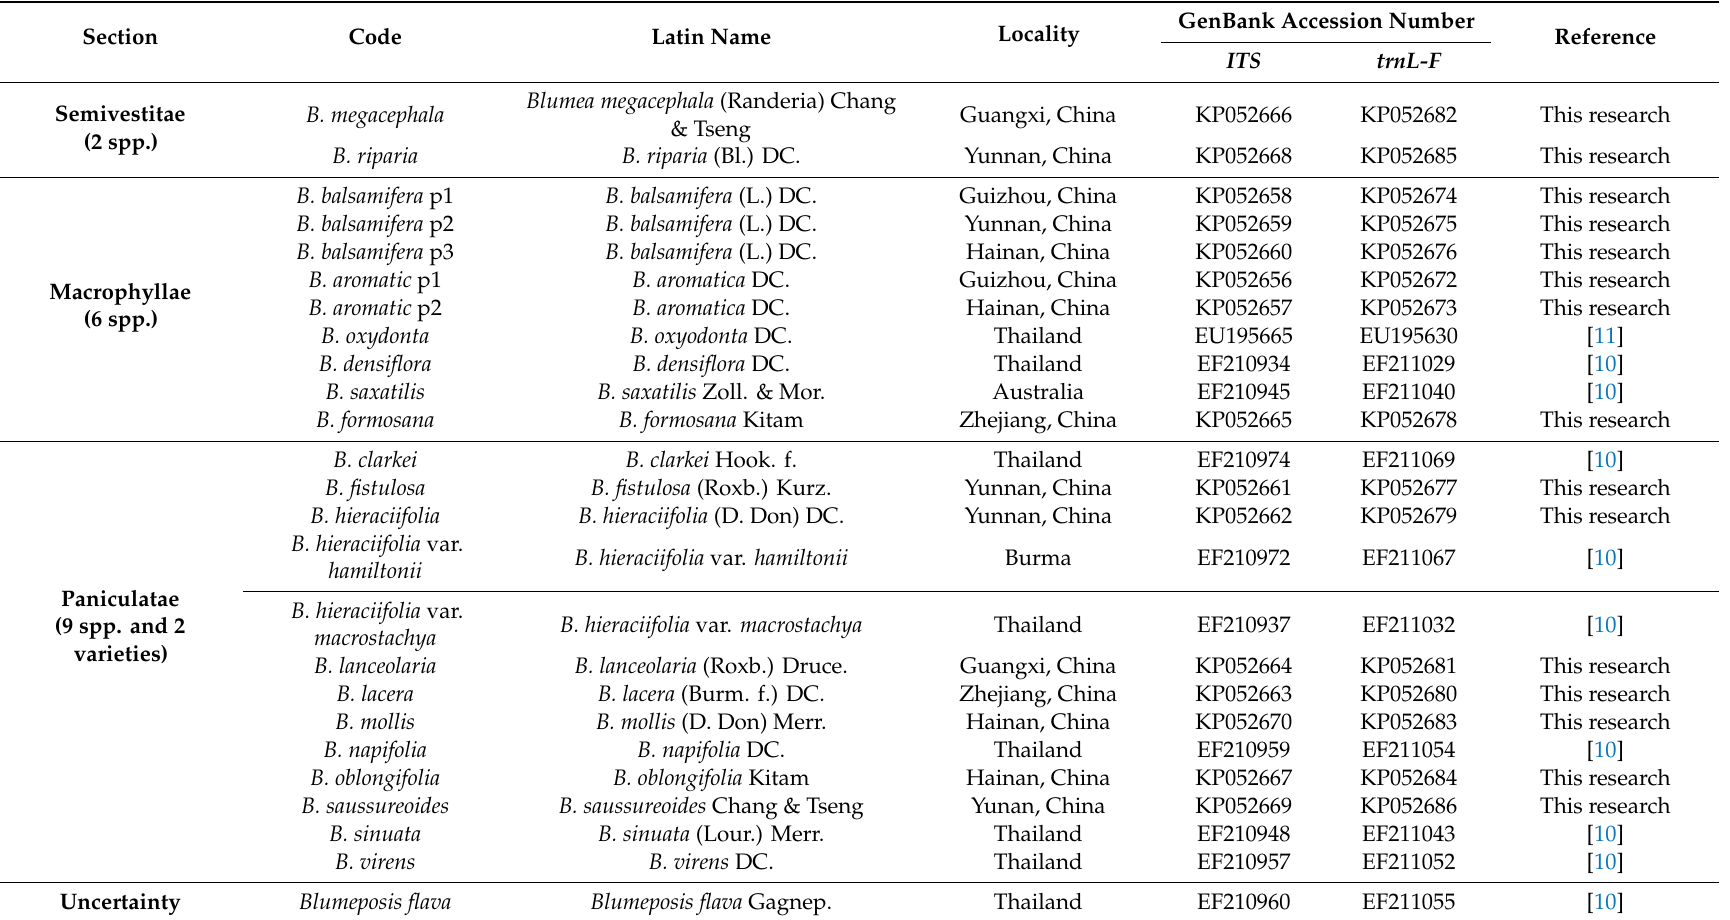
Table 3. Localities and samples used in the present